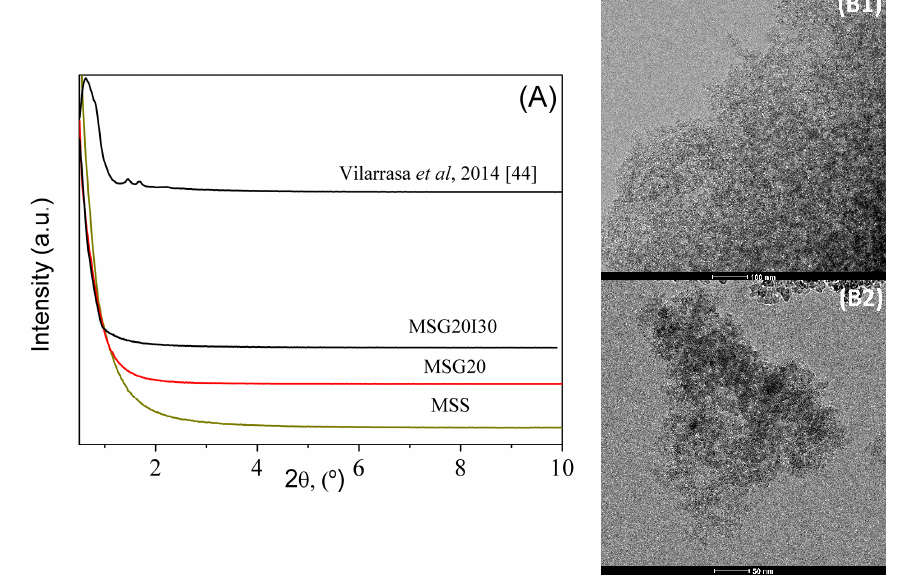
Figure 3. ( A ) X-ray powder diffraction (XRD) patterns of all mesoporous silica samples and transmission electron micrographs (TEM) micrographs of MSS with ( B1 ) scale bar = 100 nm and ( B2 ) 50 nm.